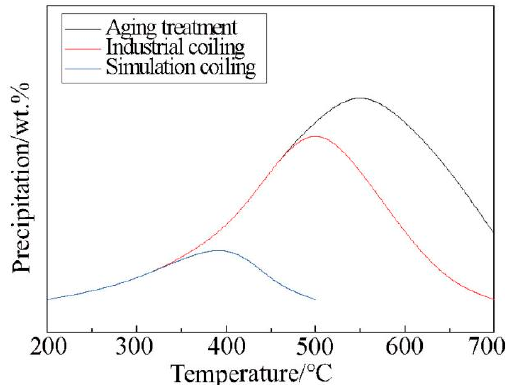
Figure 10. The relationship between the precipitation and process.